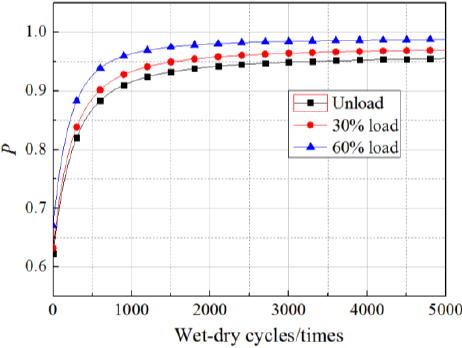
Figure 5. Change of P with wet–dry cycles.